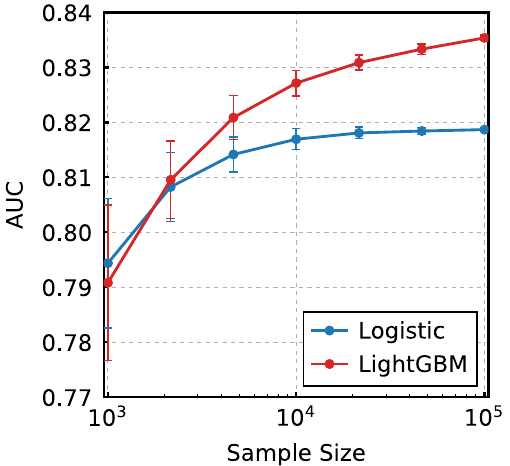
Figure 5. AUC values with various sample sizes for the LR and LightGBM